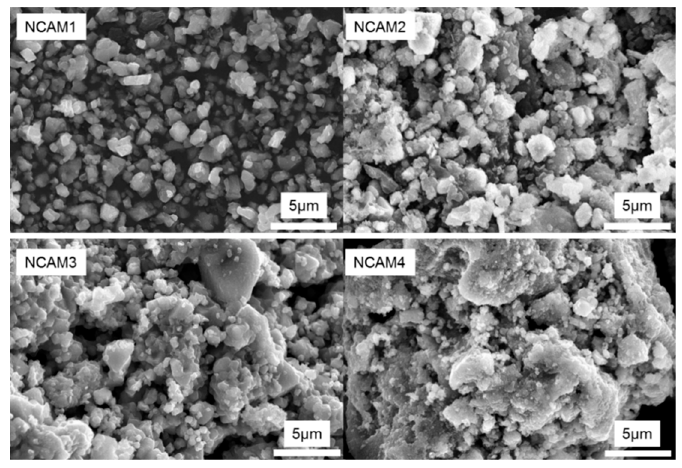
Figure 11. SEM Images of as-prepared NCA at varying precursor solution concentration.